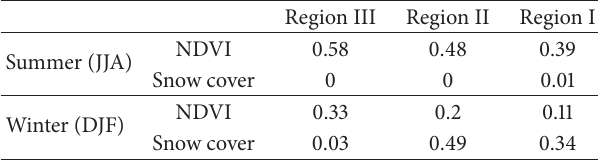
Table 6: Mean NDVI and snow cover fraction over different regions in summer and